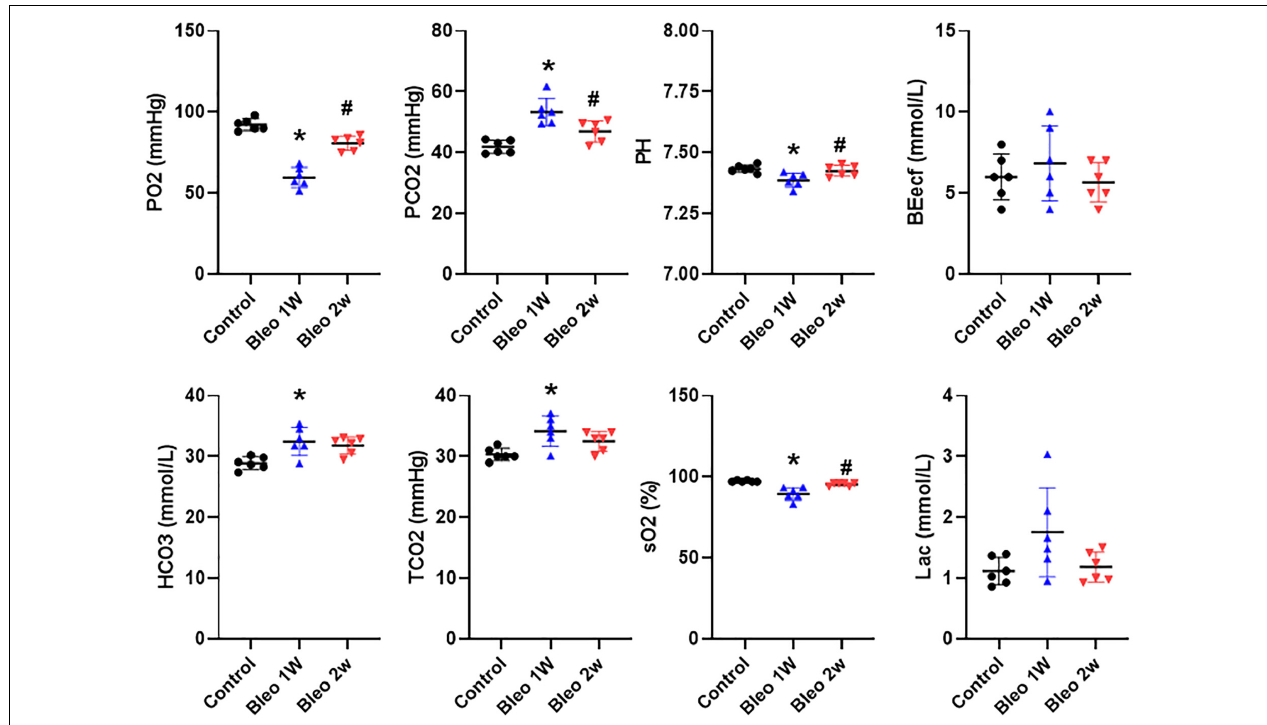
FIGURE 3 | Arterial blood gases in control, 1-week and 2-week post-Bleo rats. pCO 2 , partial pressure of carbon dioxide; pO 2 , partial pressure of oxygen; BEecf, base excess; TCO 2 , total CO 2 ; sO 2 , Oxygen saturation; Lac, lactate. Values are mean ± SD. n = 6 per group. * P < 0.05 vs. control. # P < 0.05 vs. Bleo 1w.